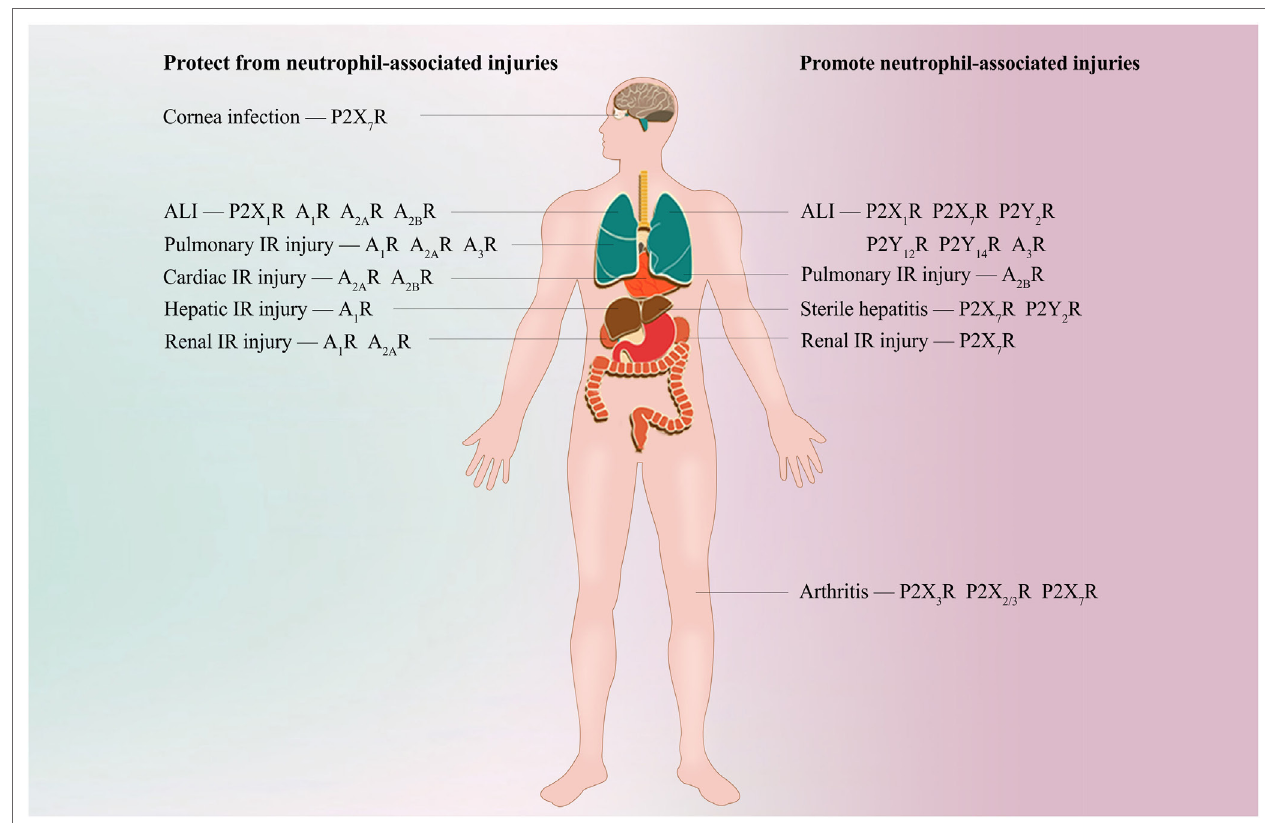
FigURe 2 | Potential purinergic targets for treating neutrophil-associated diseases. During bacterial clearance in Streptococcus pneumoniae corneal infection, agonism of neutrophil P2X 7 R is required for bacterial clearance. Inappropriate activation of P2X 7 R, P2Y 2 R, P2Y 12 R, P2Y 14 R, and A 3 R is associated with neutrophil-induced hyperinflammation and tissue damage during acute lung injury (ALI); however, A 1 R, A 2A R, and A 2B R are essential for protecting against ALI. Specific antagonism of P2Y 2 R, P2Y 12 R, P2Y 14 R, and A 3 R or specific agonism of A 1 R, A 2A R, and A 2B R alleviates neutrophil recruitment into the lung and protects against ALI. P2X 1 R exhibits a bidirectional role in neutrophil accumulation and tissue damage during ALI, but the detailed mechanisms are unclear. A 1 R, A 2A R, and A 3 R signaling frequently inhibits neutrophil infiltration and protects against tissue injuries during pulmonary, cardiac, hepatic, or renal ischemia-reperfusion (IR) injury. However, evidence shows that A 2B R is protective when activated on BM-derived cells (most likely neutrophils) in myocardial IR injury, but promote pulmonary IR injury when activated on resident pulmonary cells. During renal IR, antagonism of P2X 7 R ameliorates neutrophil infiltration and renal injury. P2X 7 R or P2Y 2 R is required for hepatic neutrophil infiltration and subsequent liver damage in thermal or chemical injury-induced sterile hepatitis, respectively. Specific inhibition of P2X 7 R or P2Y 2 R is shown to protect against neutrophil infiltration and liver inflammatory injuries. Antagonism of P2X 3 R, P2X 2/3 R, and P2X 7 R reduces neutrophil infiltration into inflamed knee joints in